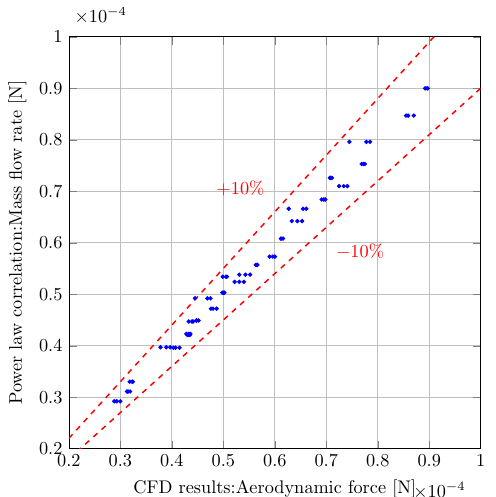
Figure 19. Mass flow rate empirical model: CFD simulations versus empirical model.